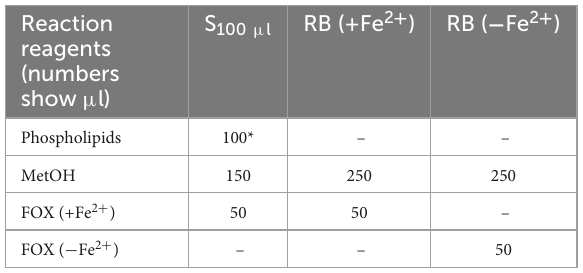
TABLE 4 Assay set up for LOOH determination in LDL phospholipids.